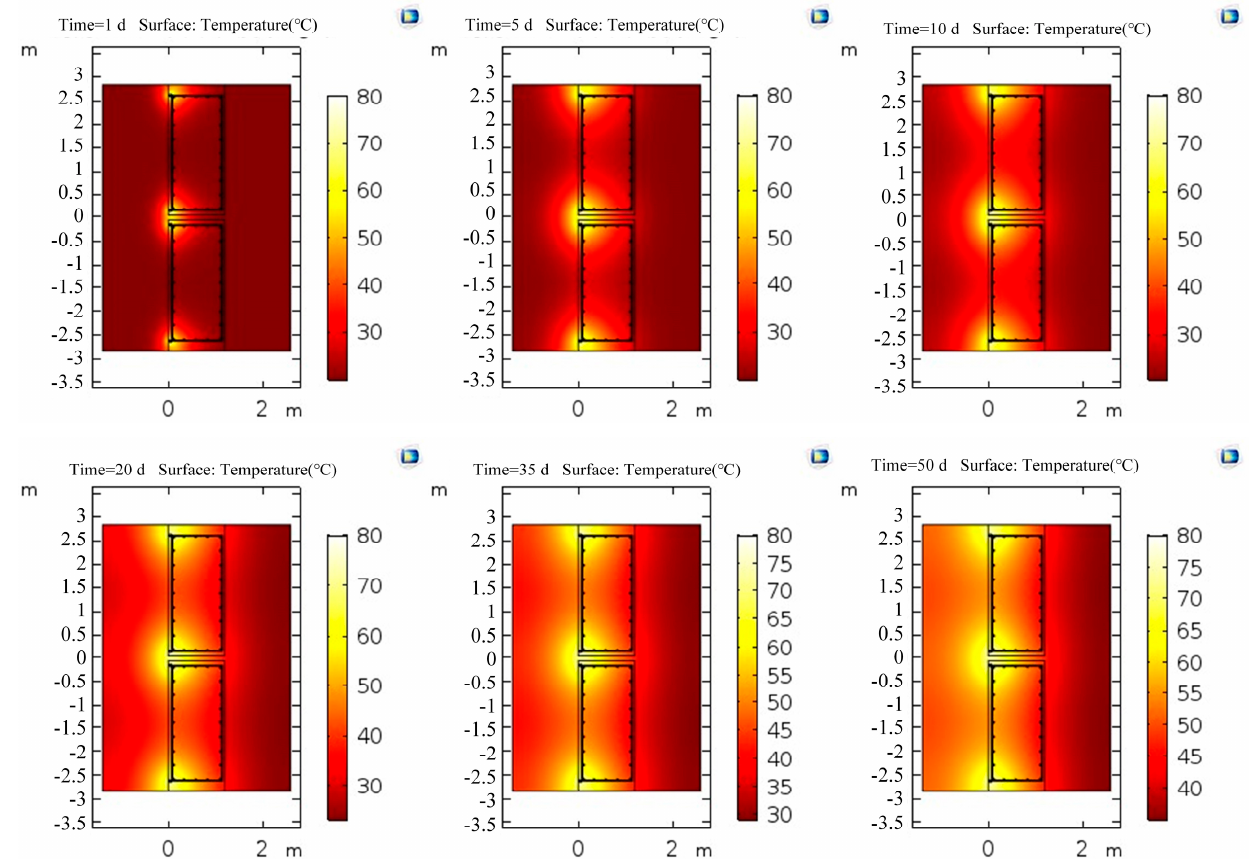
Figure 23. Distribution of temperature field in a model with tension reinforcement.